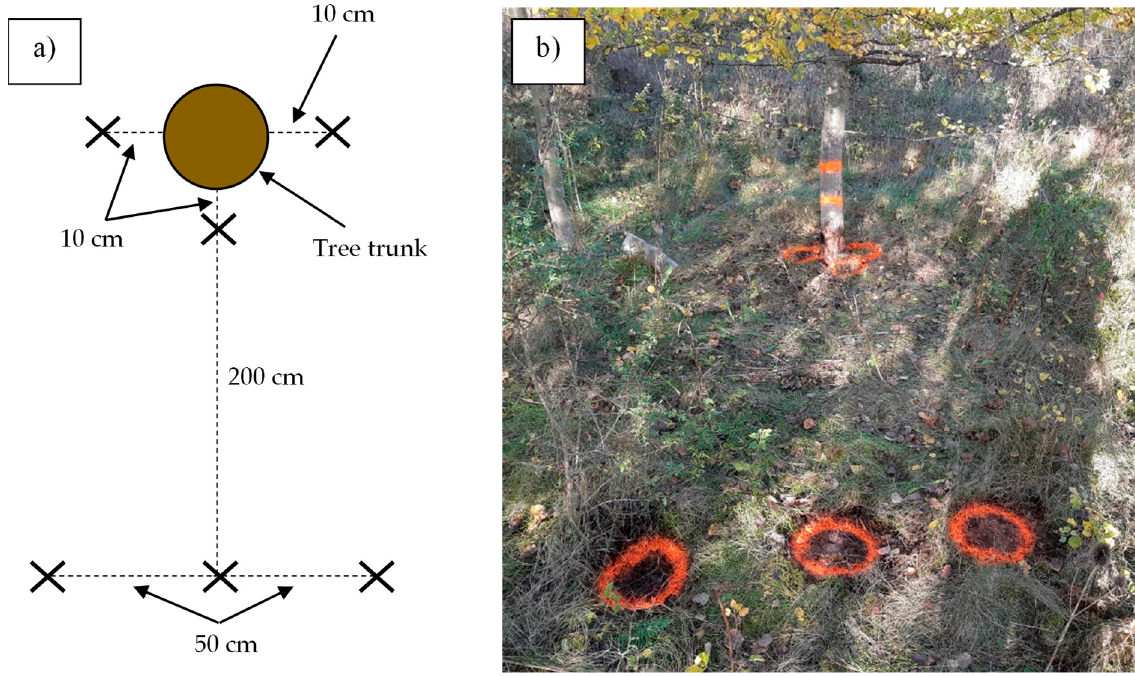
Figure 2. ( a ) Diagram of MDI measurement location in proximity to the sample tree. Black crosses (X) indicate MDI measurement location. ( b ) MDI measurement locations represented at the 2008 sample site.